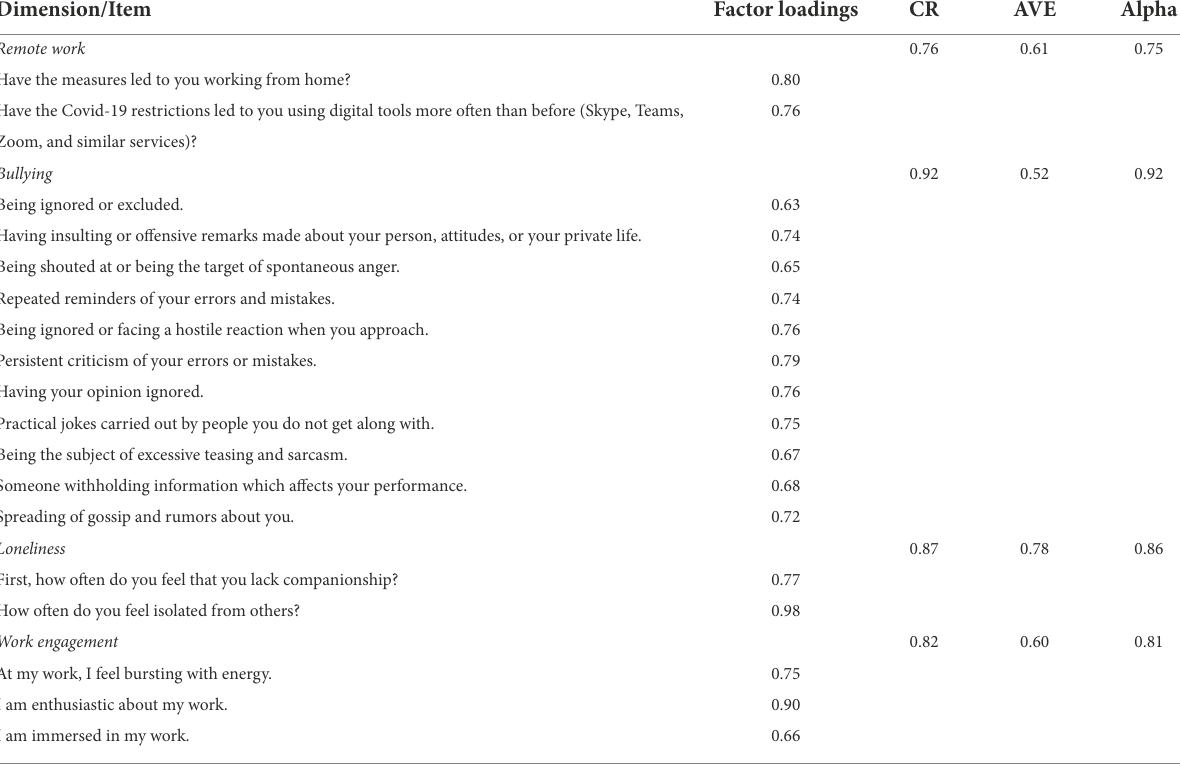
TABLE 3 Confirmatory factor loadings with standardized factor loadings, reliability, and convergent validity.